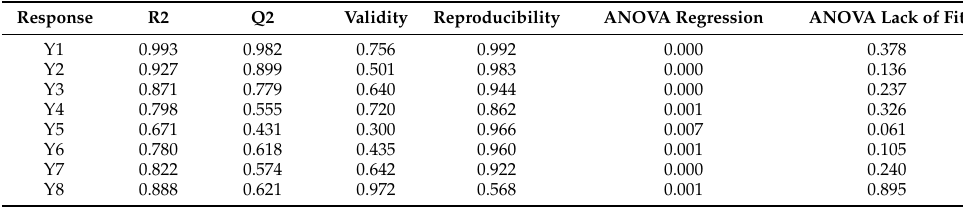
Table 4. Model performance parameters for the DoE work